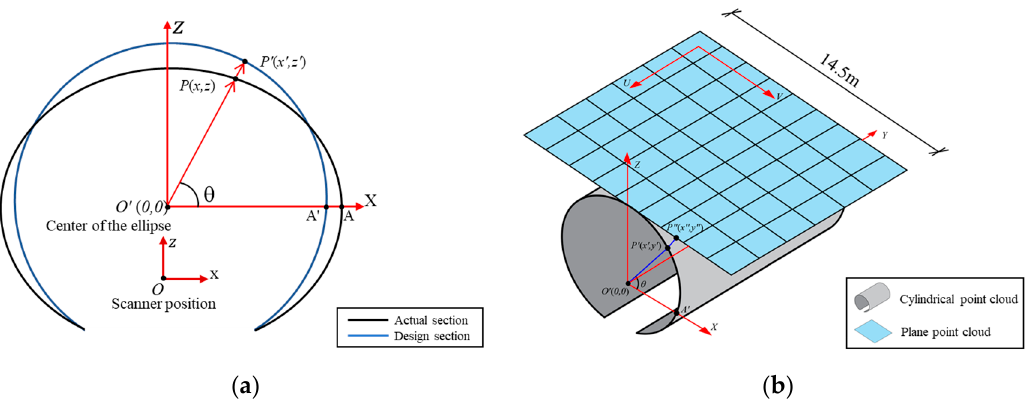
Figure 5. Point cloud unrolling: ( a ) cylindrical projection using the raw 3D point cloud data, and ( b ) converting the cylindrical point cloud onto the 2D plane.